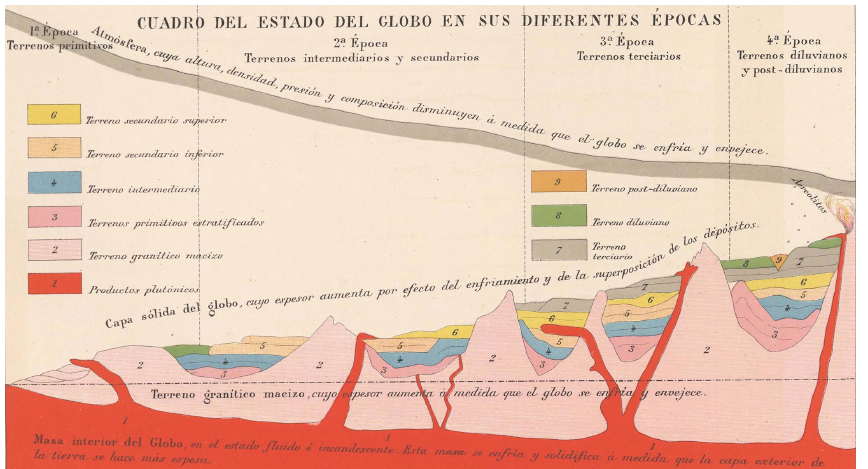
Figure 2. State of the earth through time. Numbered key: 1 – plutonics (fused), 2 – granitic terrane, 3 – stratified primitive terrane, 4 – intermediary terrane, 5 – lower secondary terrane, 6 – upper secondary terrane, 7 – Tertiary terrane, 8 – diluvial terrane, 9 – post-diluvial terrane. Note the transition from the first epoch (primitive terrane), to the second (secondary and intermediary terranes), to the third (Tertiary terranes), to the fourth (diluvial and post-diluvial terranes). From left to right, the stratigraphic column builds upon a “granitic terrane [pink], whose thickness increases as the earth ages and cools” (“terreno granítico macizo, cuyo espesor aumenta a medida que el globo se enfría y envejece”). The dashed line is present sea level. Above this line is a “[g]lobal solid layer whose thickness increases the effect of cooling and superposition of deposits” (“Capa sólida del globo, cuyo espesor aumenta por efecto del enfriamiento y de la superposición de los depósitos”). “Inside the globe, in the fluid state and [is an] incandescent mass [red]. “This mass is cooled and solidifies along with the outer layers of the earth” (“Masa interior del Globo, en el estado fluido é incandescente. Esta masa se enfría y solidifica á medida que la capa exterior de la tierra se hace mas espera”). Note feeder dikes emanating from this mass, the magma source for volcanoes. At the top is the “[a]tmosphere, whose height, density, pressure and composition decrease as the earth is cooled and aged” (“Atmósfera, cuya altura, densidad,